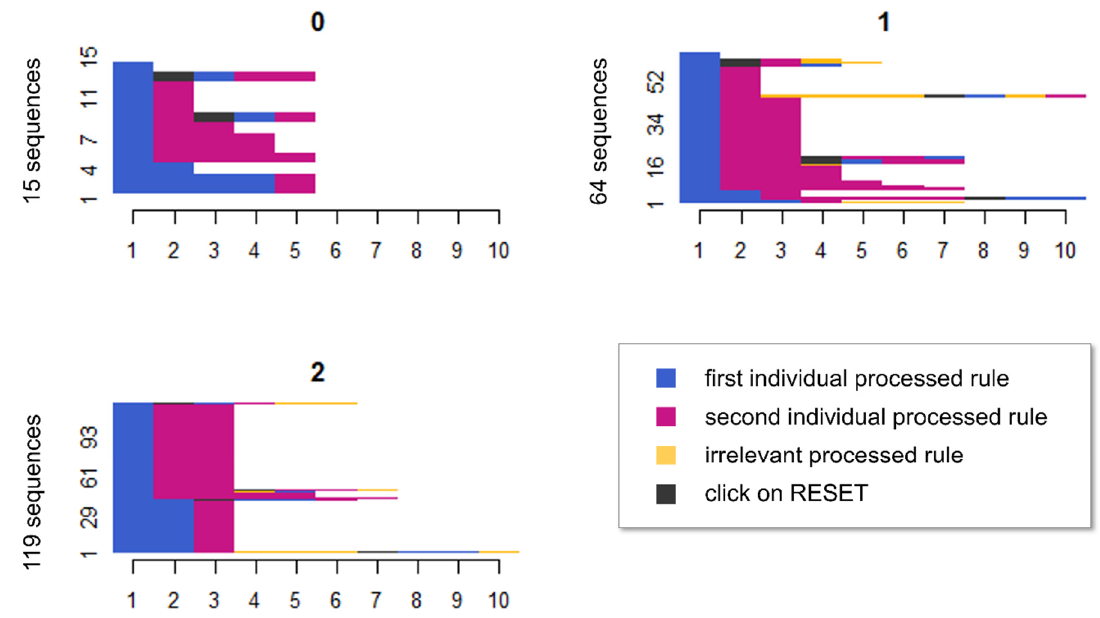
Figure 4. The figure shows the sequence diagrams for each number of correct partial solutions. The number to the left of the diagram represents the number of participants with the respective number of correctly solved partial solutions (in the example: 15 participants did not achieve any partial solution, 64 participants achieved one partial solution and 119 participants achieved two partial solutions). To provide a clearer structure, the participants’ sequences are ordered in such a way that identical sequences are placed next to each other; x -axis = number of clicks, y -axis = number of participants, blue = first individual processed rule, red = second individual processed rule, yellow = third individual processed rule; gray = click on RESET.